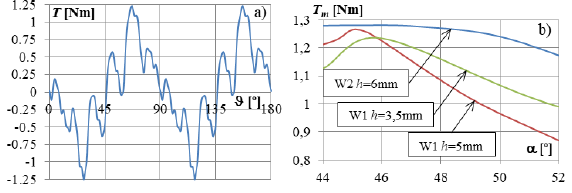
Fig. 3. Characteristics T (  ) (a) and dependence T m (  ) (b) .